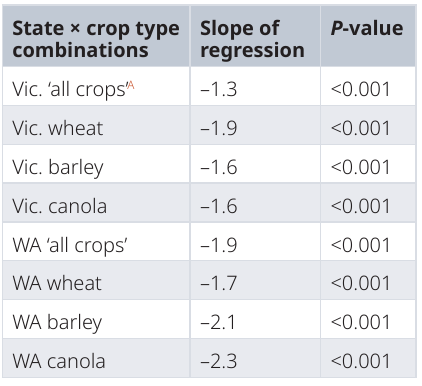
Table 2. Linear regression analysis of sowing date (SD, Julian days) vs year with records of >30 Trial projects available for that state × crop type